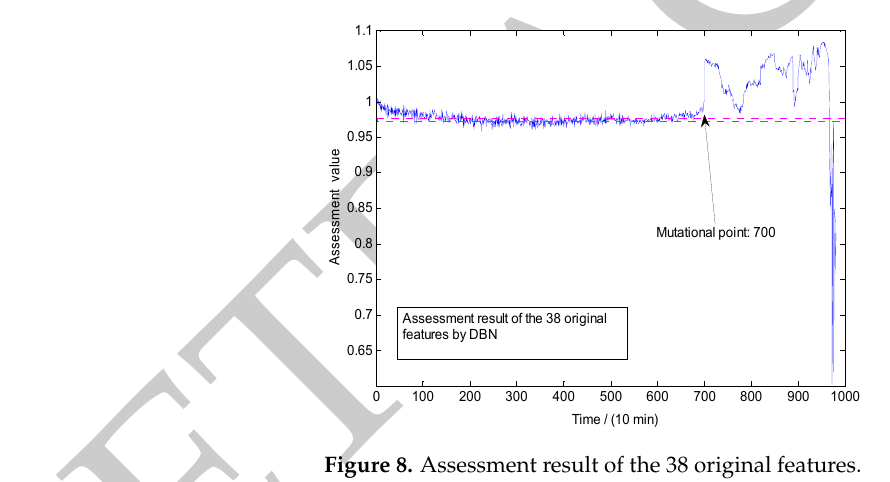
Figure 8. Assessment result of the 38 original features.